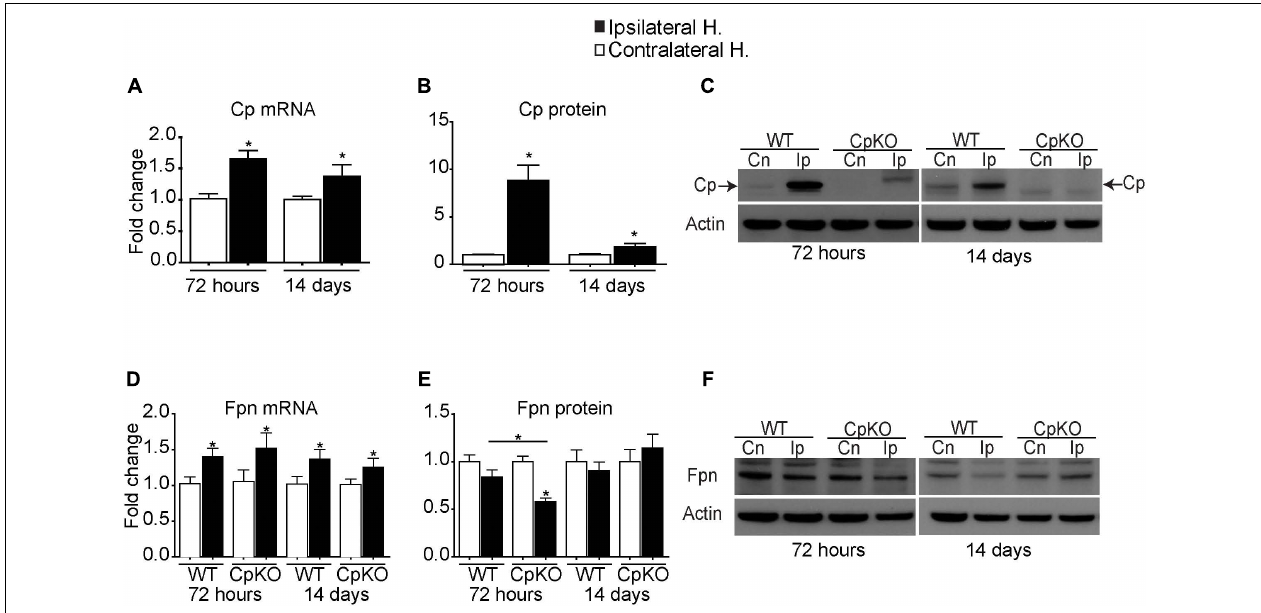
FIGURE 2 | Changes in mRNA detected by q-PCR and protein expression detected by Western blot analysis of Cp (A–C) and Fpn (D–F) in the ipsilateral ischemic side as compared to the contralateral uninjured side at 72 h and 14 days after pMCAO. Changes in the ipsilateral ischemic side are represented as fold-change as compared to contralateral uninjured side. Changes in expression of Cp mRNA (A) , and protein (B) quantified from Western blots; a representative example of the Western blot for Cp is shown (C) . Note the marked increase in Cp protein at 72 h (8.8-fold) and which remains significantly elevated (twofold) at 14 days. (C) The weak bands seen on the ipsilateral side in the Cp null mice are non-specific bands that are not at the expected 135 kDa GPI-Cp band (arrows). Changes in Fpn mRNA (D) and protein (E) and representative Western blots (F) . Fpn is significantly reduced on the ipsilateral side in Cp null mice at 72 h. β actin was used as a loading control. n = 6 per group; ∗ p -value ≤